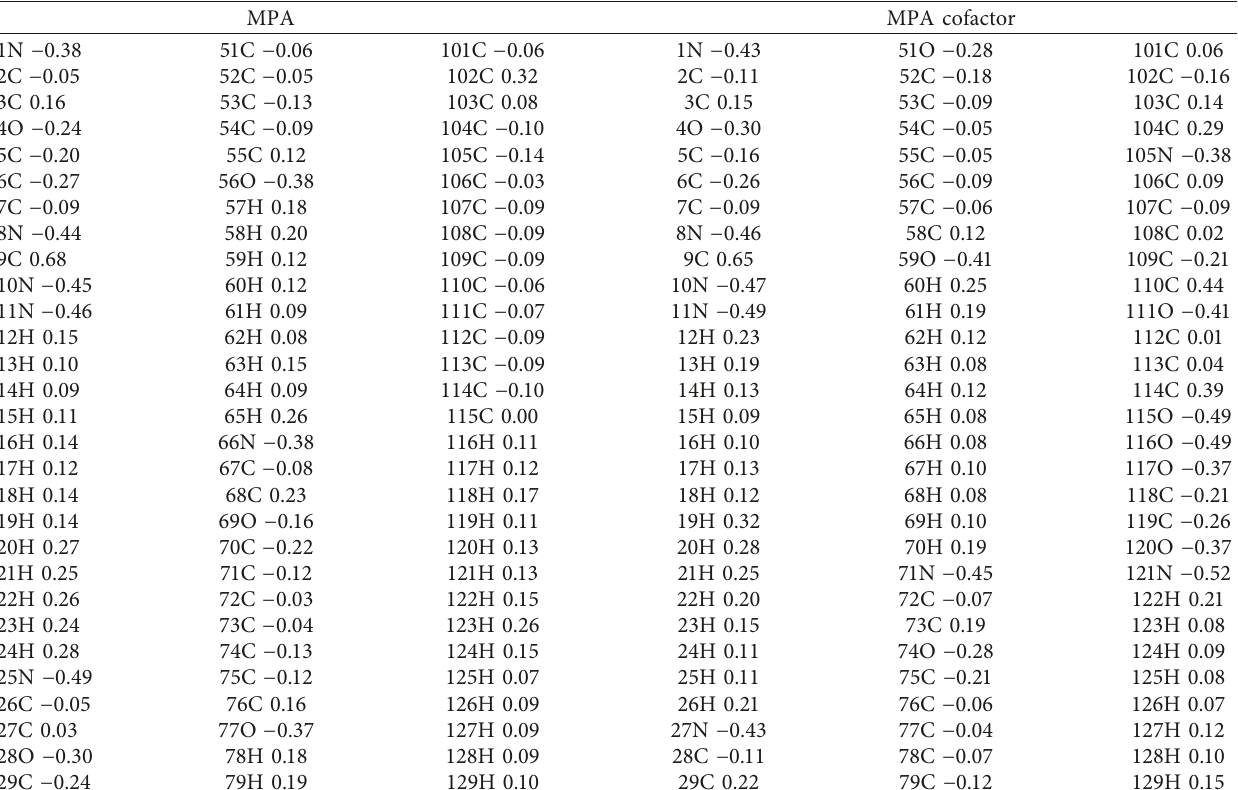
Figure 6: (a) Pymol view of HSA-coumarin derivative complex hydrogen bonding interaction with active site residues. (b) Charge distribution (DFT) analysis plot for the HSA-coumarin derivative complex of active site residues. Table 4: The calculated Mulliken population analysis (MPA) of the coumarin molecule with active site amino acids of